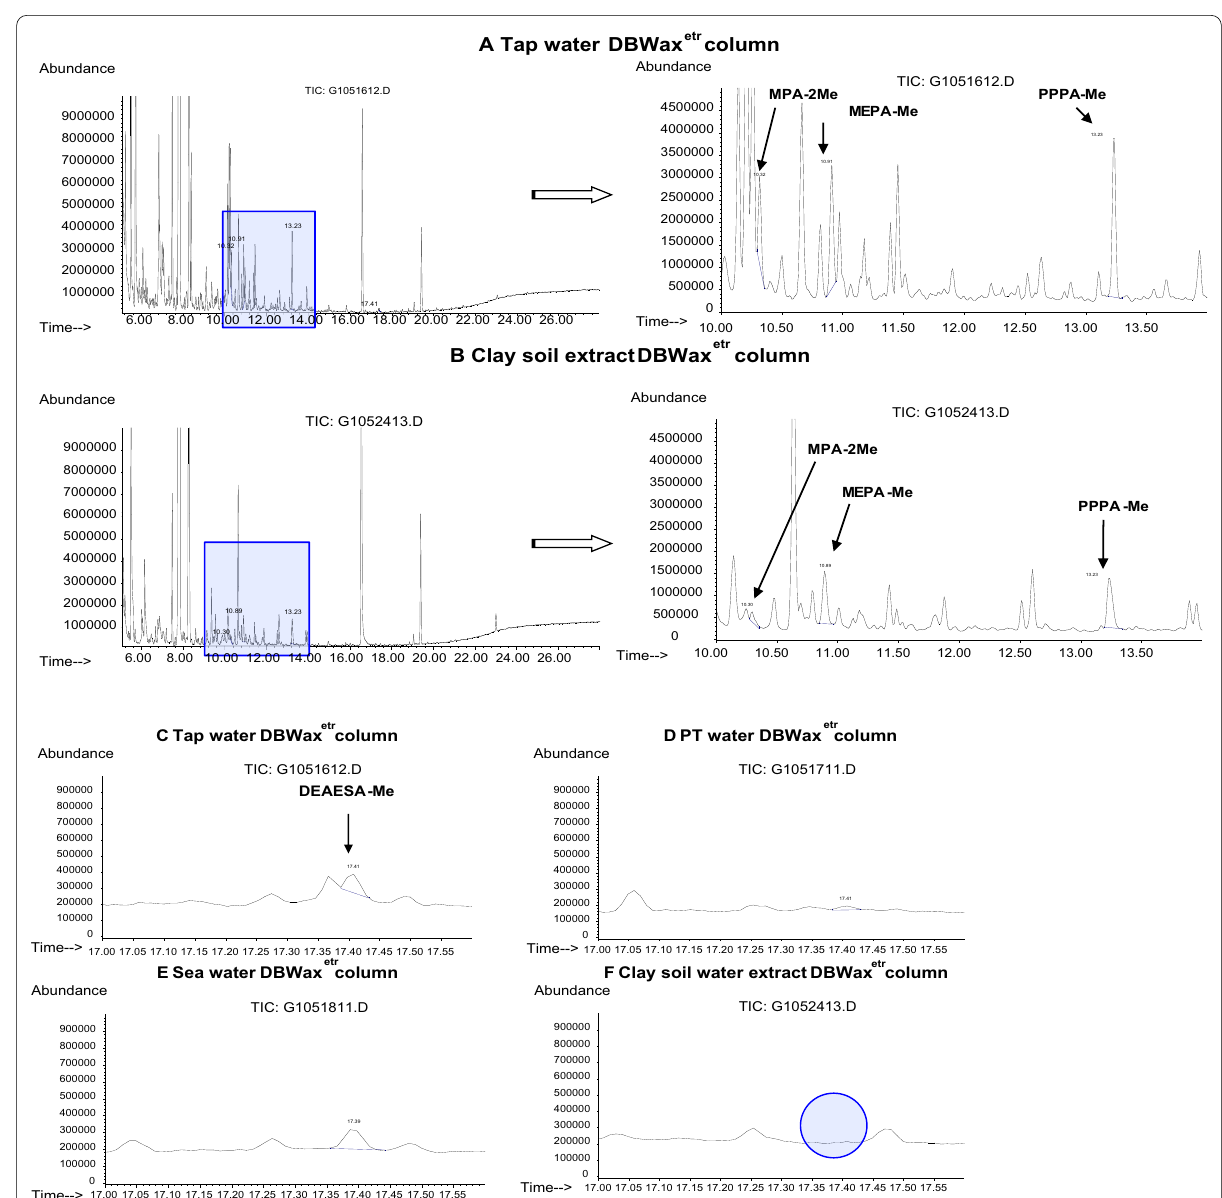
Fig. 5 GC–MS TICs of non‑cation‑exchanged water samples and clay extract. TMSDAM was used for methylation of a tap water sample ( A ) and a clay soil extract ( B ). Retention time window during which the DEAESA derivative elutes for a tap water sample ( C ), a PT water sample ( D ), a seawater sample ( E ) and a clay soil extract ( F ). A DBWaxetr column was